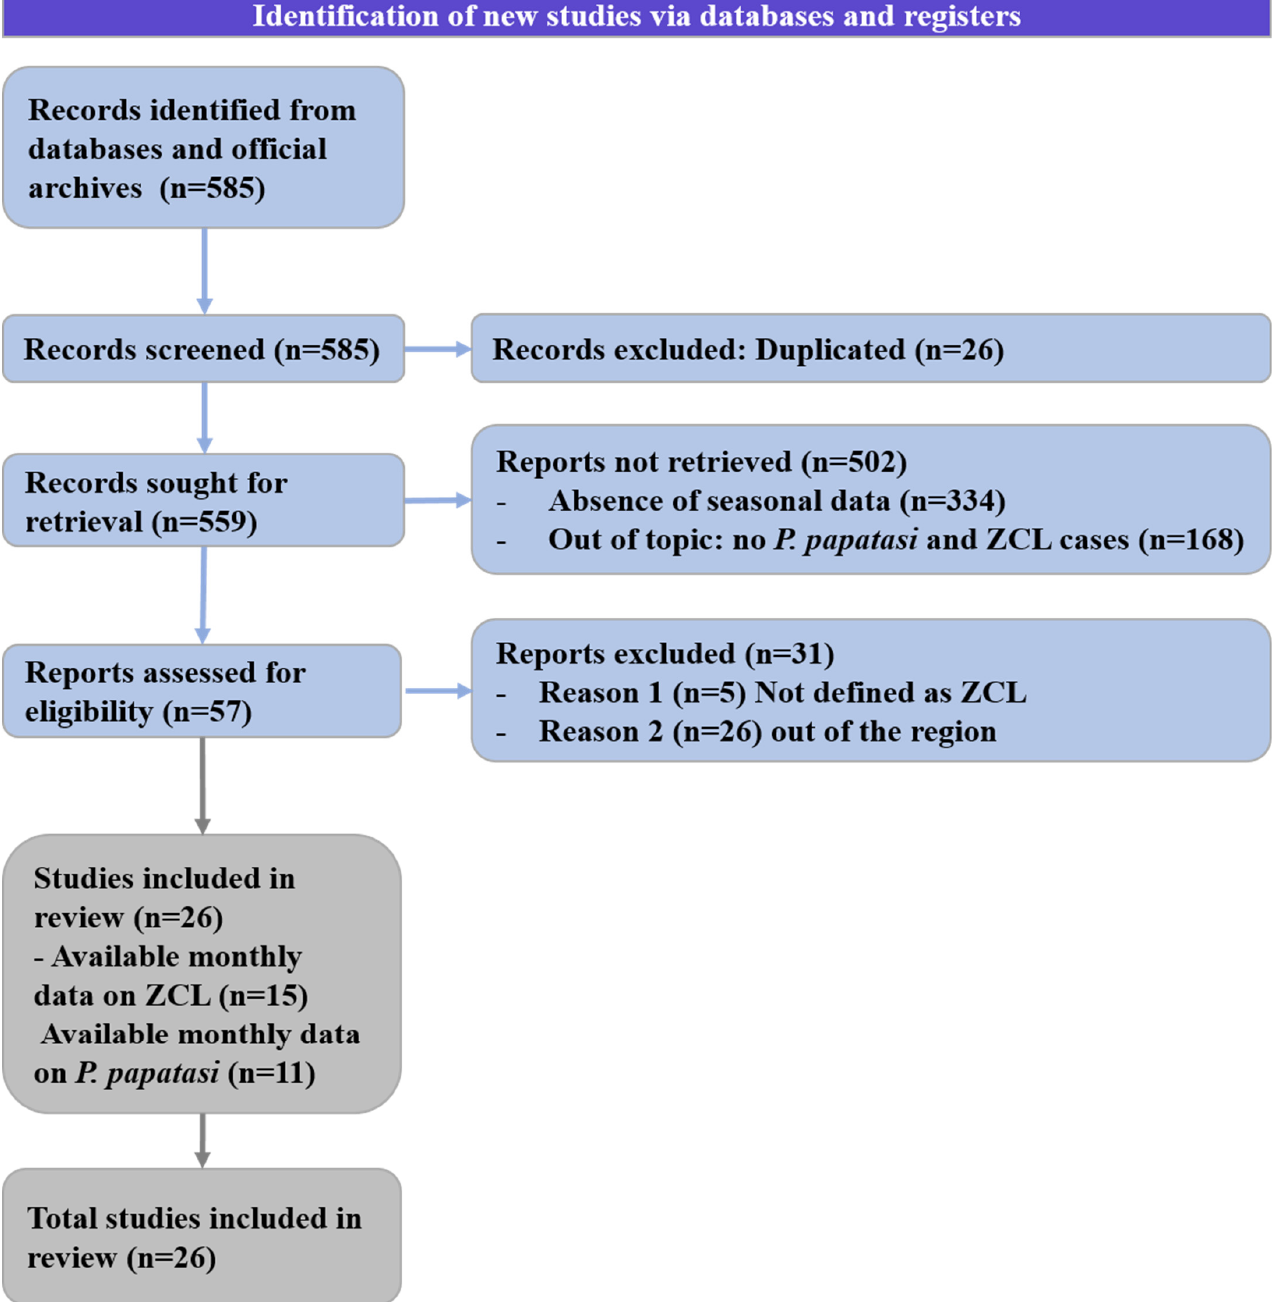
Figure 1. Flow chart of the current study following the recent updates of the PRISMA guidelines of 2020.